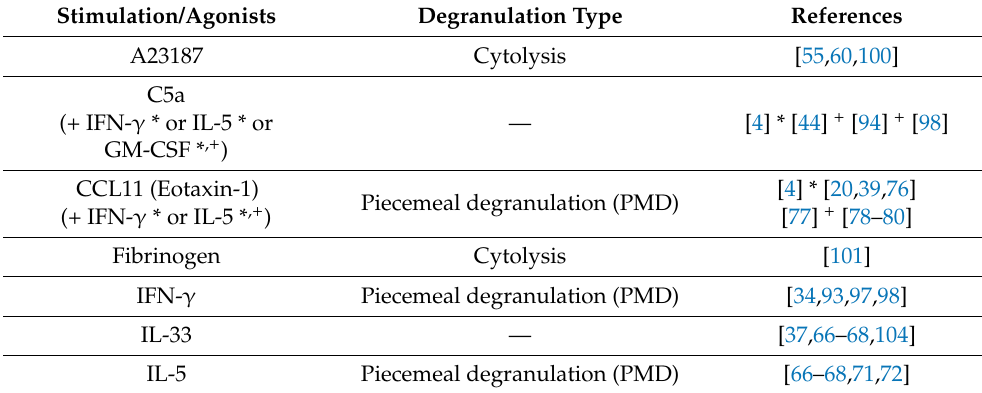
Table 1. Stimulation and agonists used to assess different modes of eosinophil